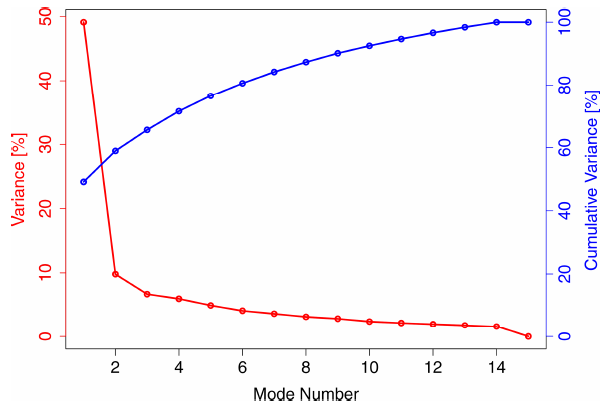
Figure 6. The percentage variances and cumulative variances based on the summer remote-sensing-derived p CO 2 data for the period of